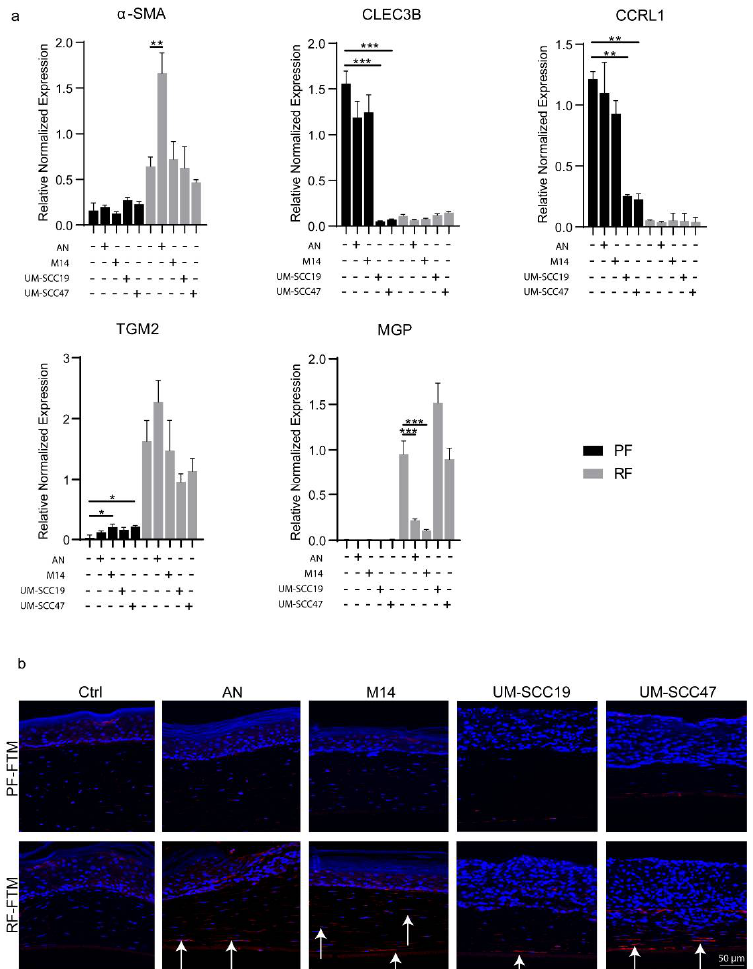
Figure 6. RF started to receive CAF phenotype after interaction with tumor cells. ( a ) The mRNA expression of α-SMA, CLEC3B, CCRL1, TGM2 and MGP in PFs and RFs co-cultured with AN, M14, UM-SCC19 or UM-SCC47. ( b ) α -SMA was stained in PF-FTMs and RF-FTMs with primary keratinocytes, AN, M14, UM-SCC19 or UM-SCC47 epidermis. Arrows indicate the expression of the biomarker. Data was obtained from three independent experiments and is presented as mean ± standard deviation (SD); * p < 0.05, ** p < 0.01, *** p <